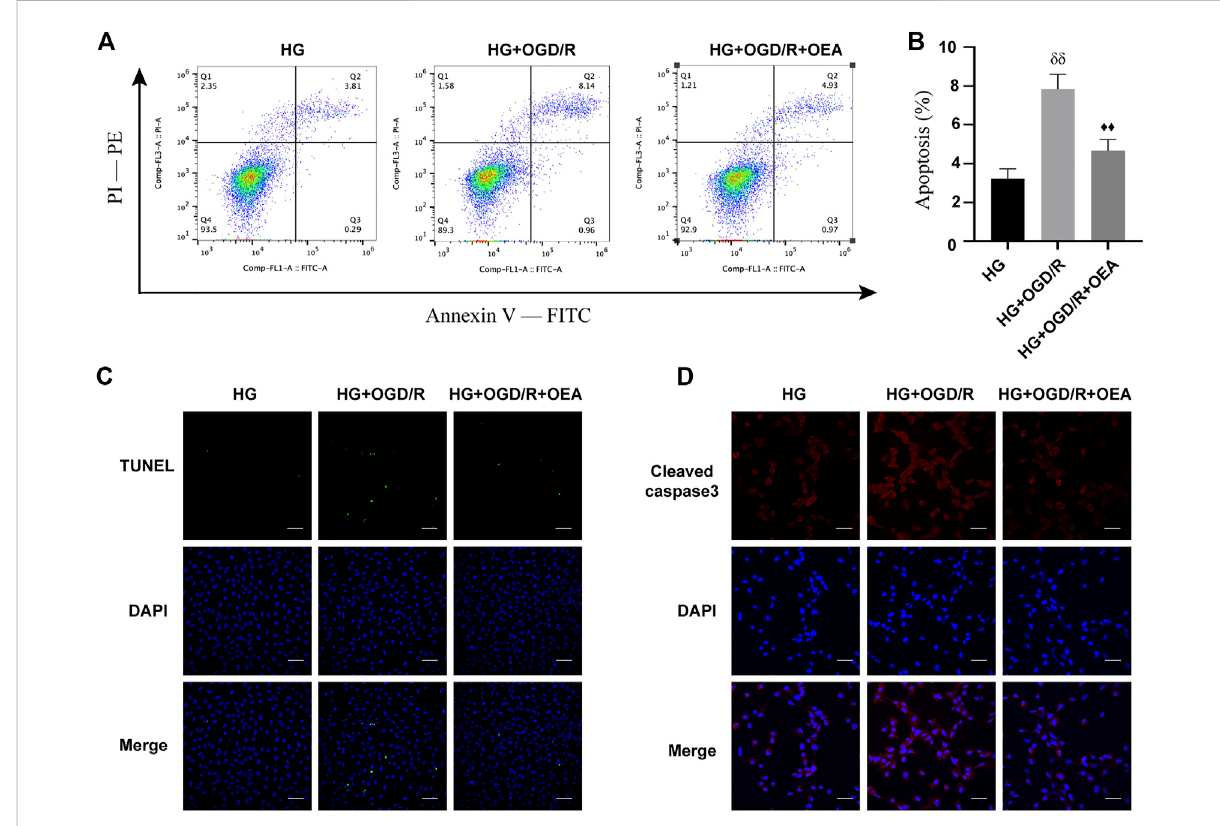
FIGURE 6 OEA inhibited the apoptosis of H9C2 cells after OGD/R induced by high glucose. (A) Flow cytometry was performed on each group of cells using FITC/PE channel. Annexin V fl uorescence intensity was represented on the horizontal axis. PI fl uorescence intensity was represented on the vertical axis, and Q2 region represents the number of apoptotic cells. (B) Statistical analysis of apoptotic cells was carried out by fl ow cytometry ( n = 3). (C) DAPI fl uorescent dye (nucleus, blue) and TUNEL (green) were used for immuno fl uorescence staining of cells in each group, scale